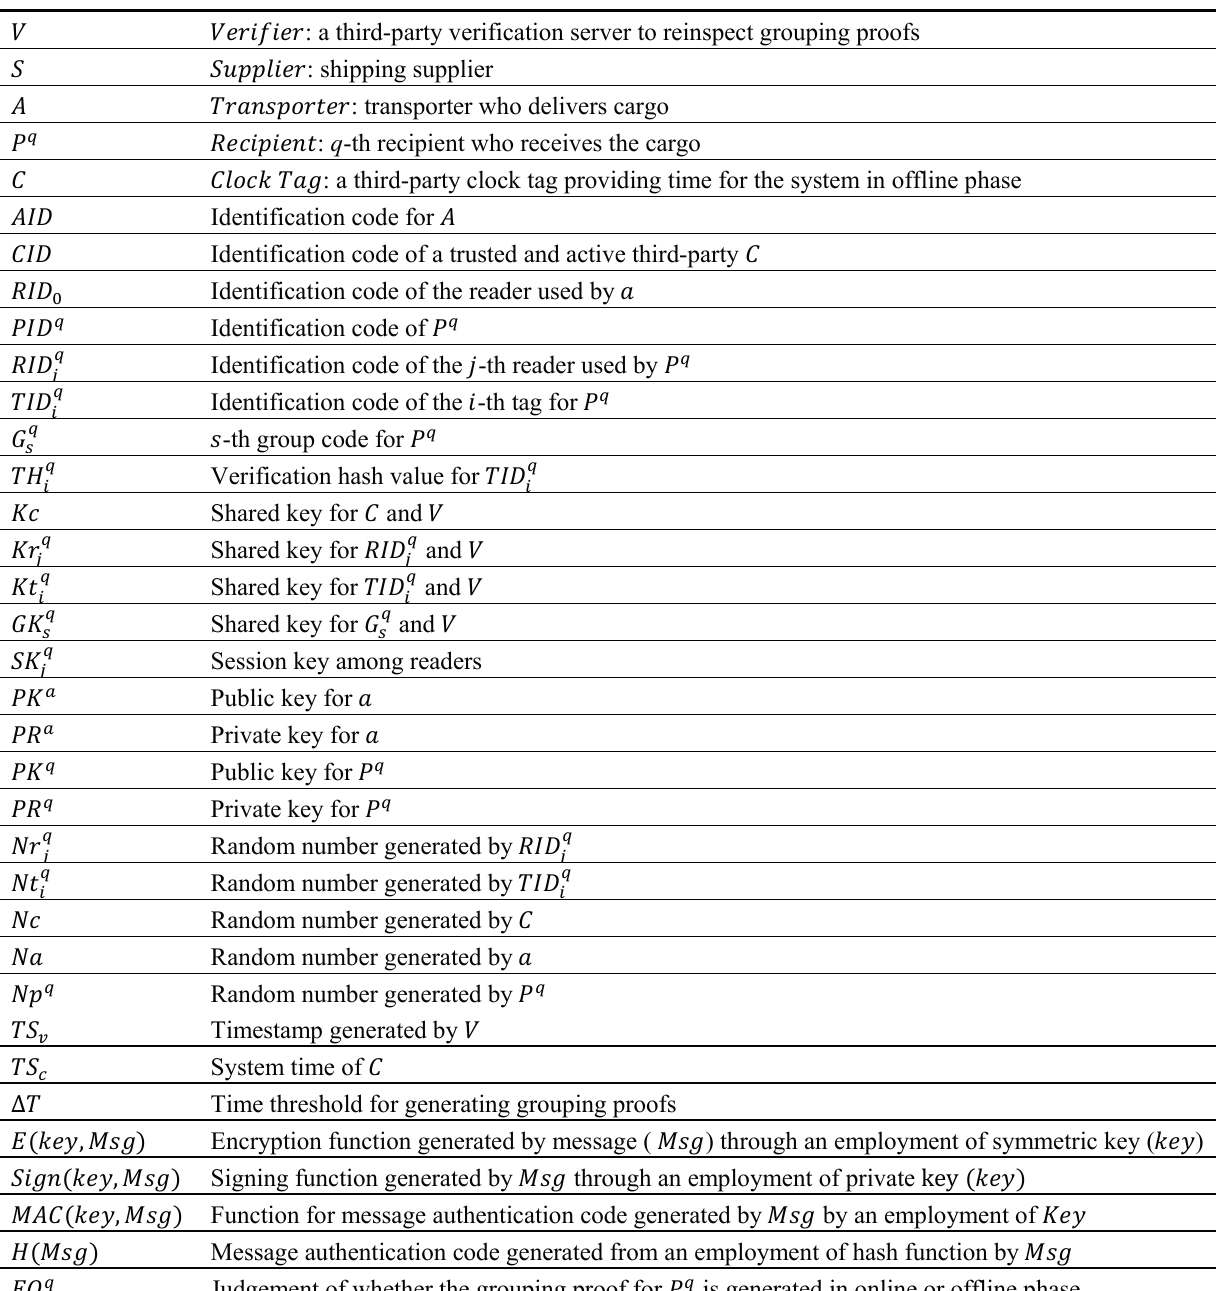
Table 1. Definition of